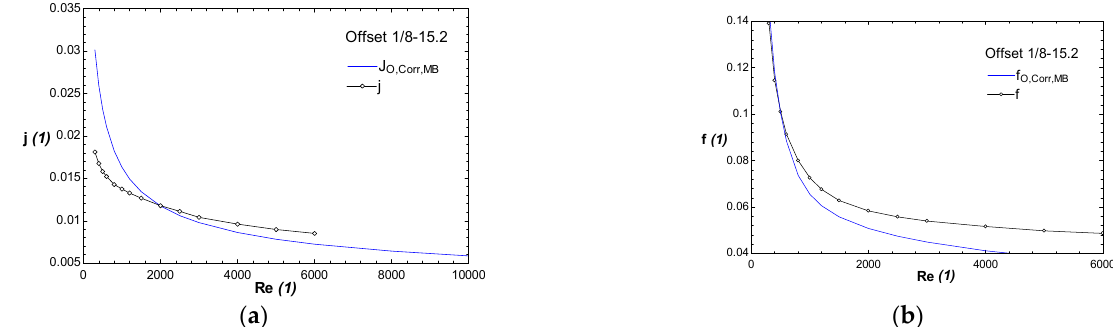
8 of 19 Table 3. Correlations for several heat transfer surfaces. Expression